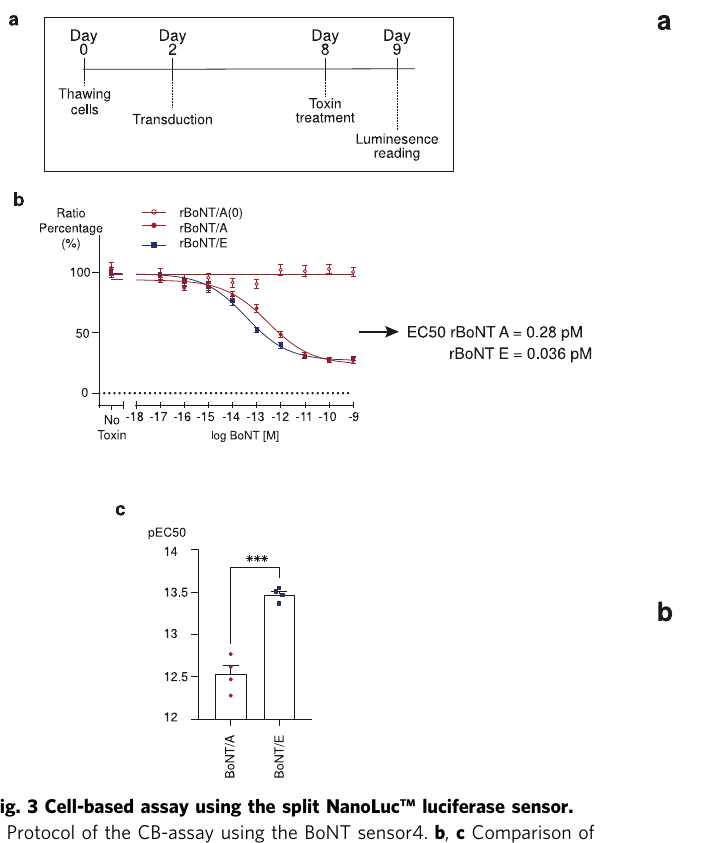
Fig. 3 Cell-based assay using the split NanoLuc ™ luciferase sensor. a Protocol of the CB-assay using the BoNT sensor4. b , c Comparison of rBoNT/A (0) (red empty circles), rBoNT/A (red circles) and rBoNT/E (blue squares) potency in the BoNT sensor4 CB-assay. Data points are mean of n = 4 independent experiments in triplicate. b Graph shows concentration – response curves. c Comparison of the pEC50 of rBoNT/A and E calculated from curves above. Statistical two-tailed Student ’ s t -tests: * P < 0.05; ** P < 0.01; *** P < 0.001; NS, P > 0.05 not signi fi cant (NS). Error bars show SEM.